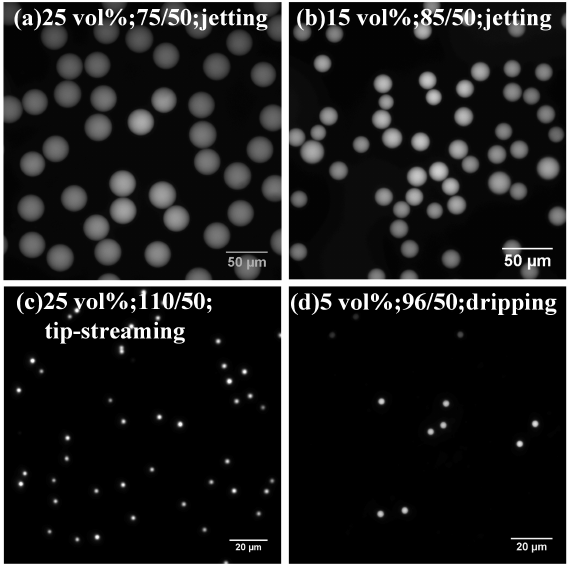
Figure 4. Fluorescent images of PEGDA droplets produced under different conditions. The average diameters and coefficients of variation of droplets in ( a – d ) are 32.15 µ m and 4.44%, 17.50 µ m and 9.62%, 3.29 µ m and 16.15%, 3.36 µ m and